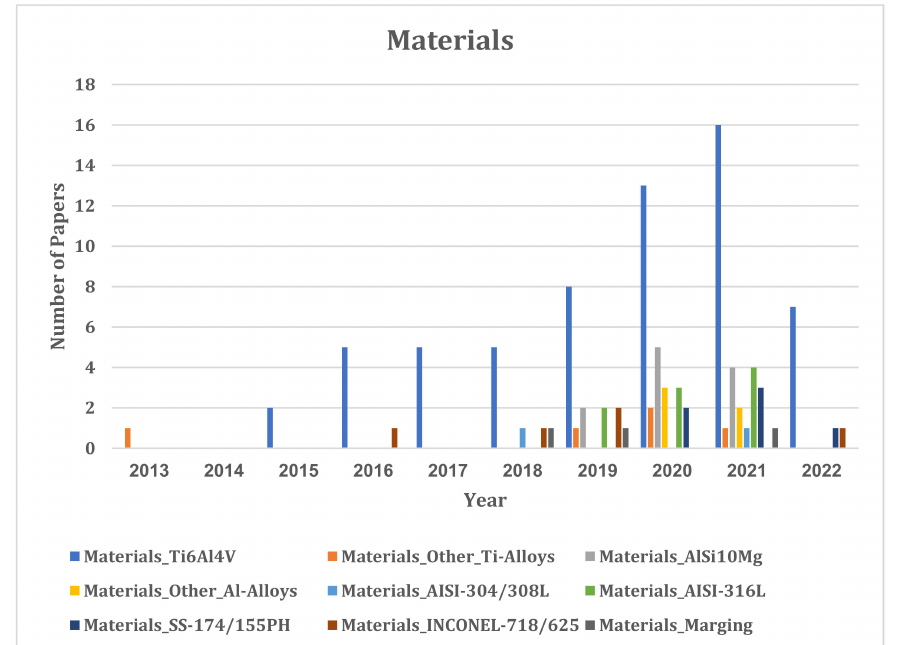
Figure 3. Additive Manufacturing